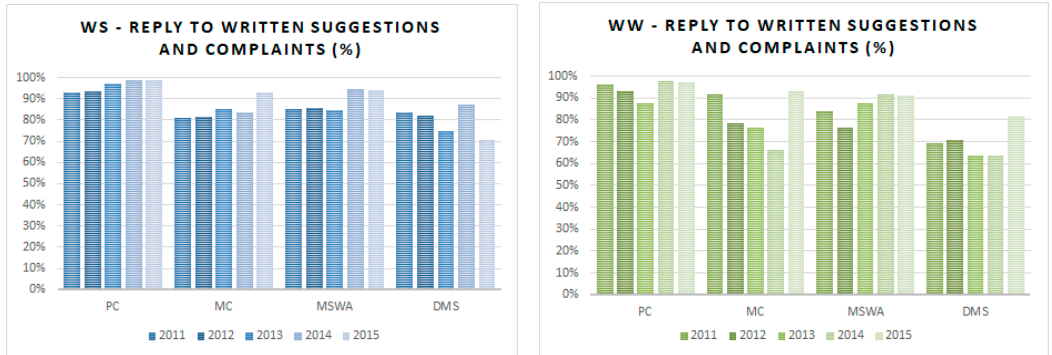
Figure 6. Customer service in water (left) and wastewater services (right).